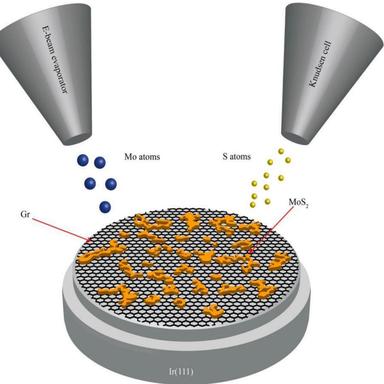
Schematic representation of a MoS2 synthesis.